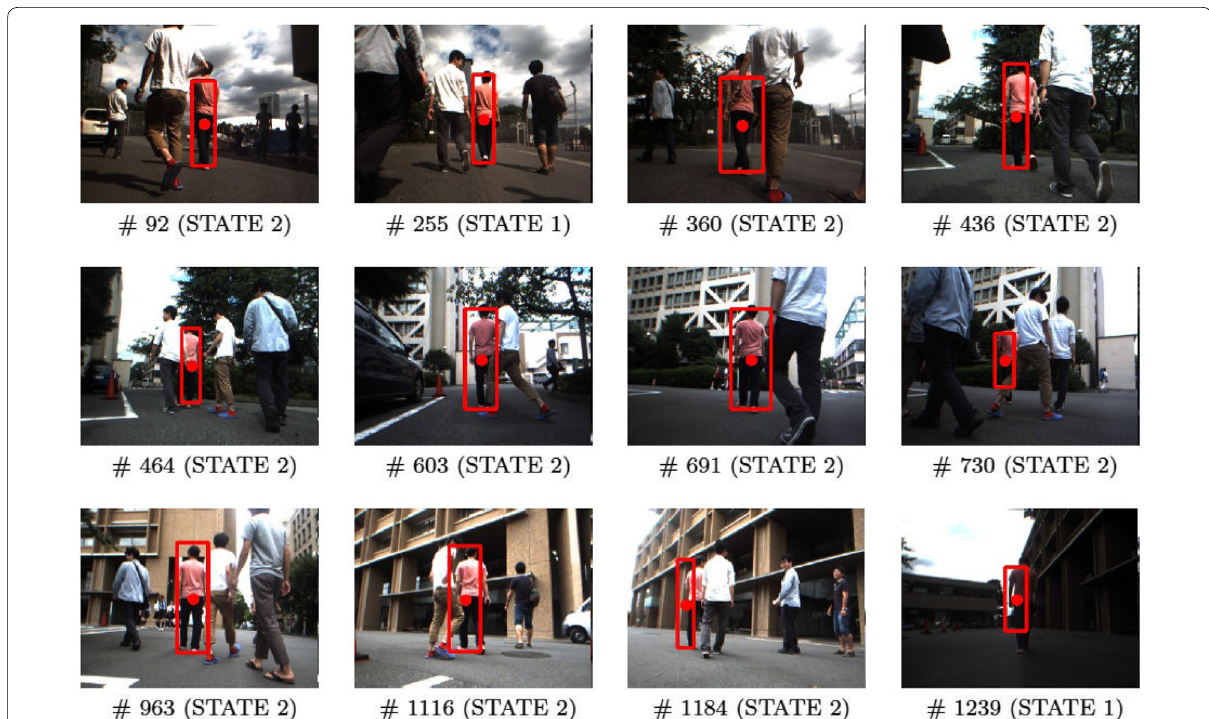
Fig. 11 Result of target identification in the on-line experiments. The frame number and occlusion state which is classified by using the proposed method, are shown under each image